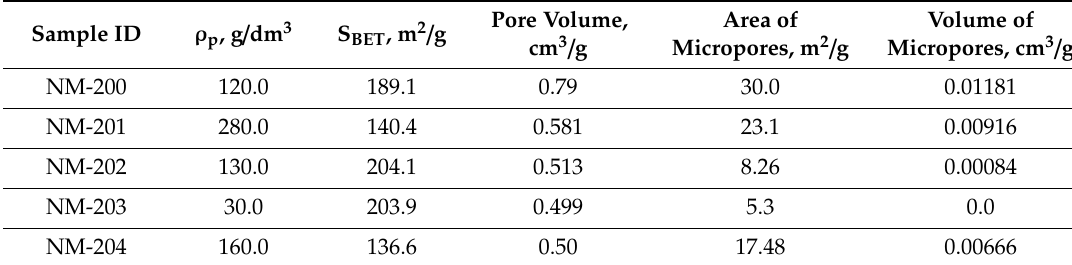
Table 4. Pore characteristics of pyrogenic and precipitated SiO 2 nanopowders [1] established by the